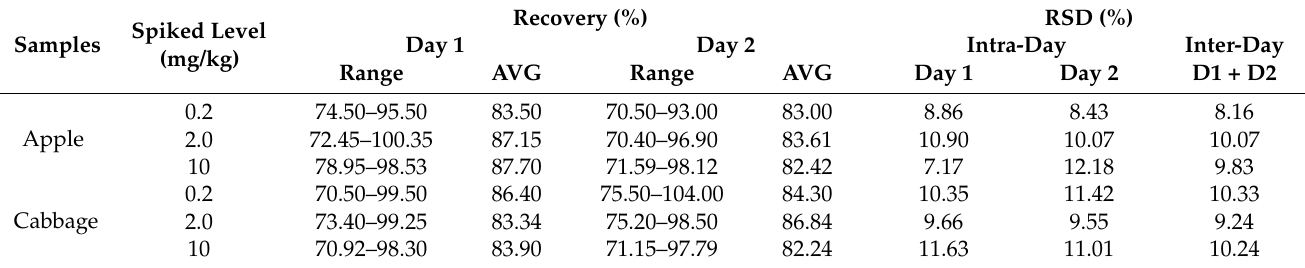
Table 1. The results of detecting pymetrozine in the spiked apple and cabbage samples.